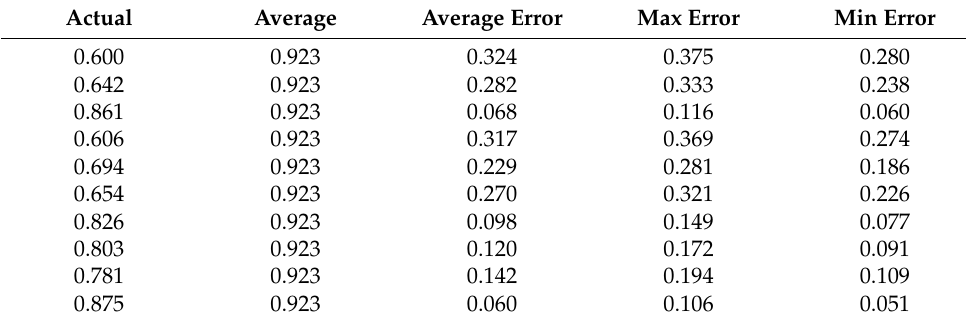
Table A98. Set 2, trials 11–20 data (average actual PR values).